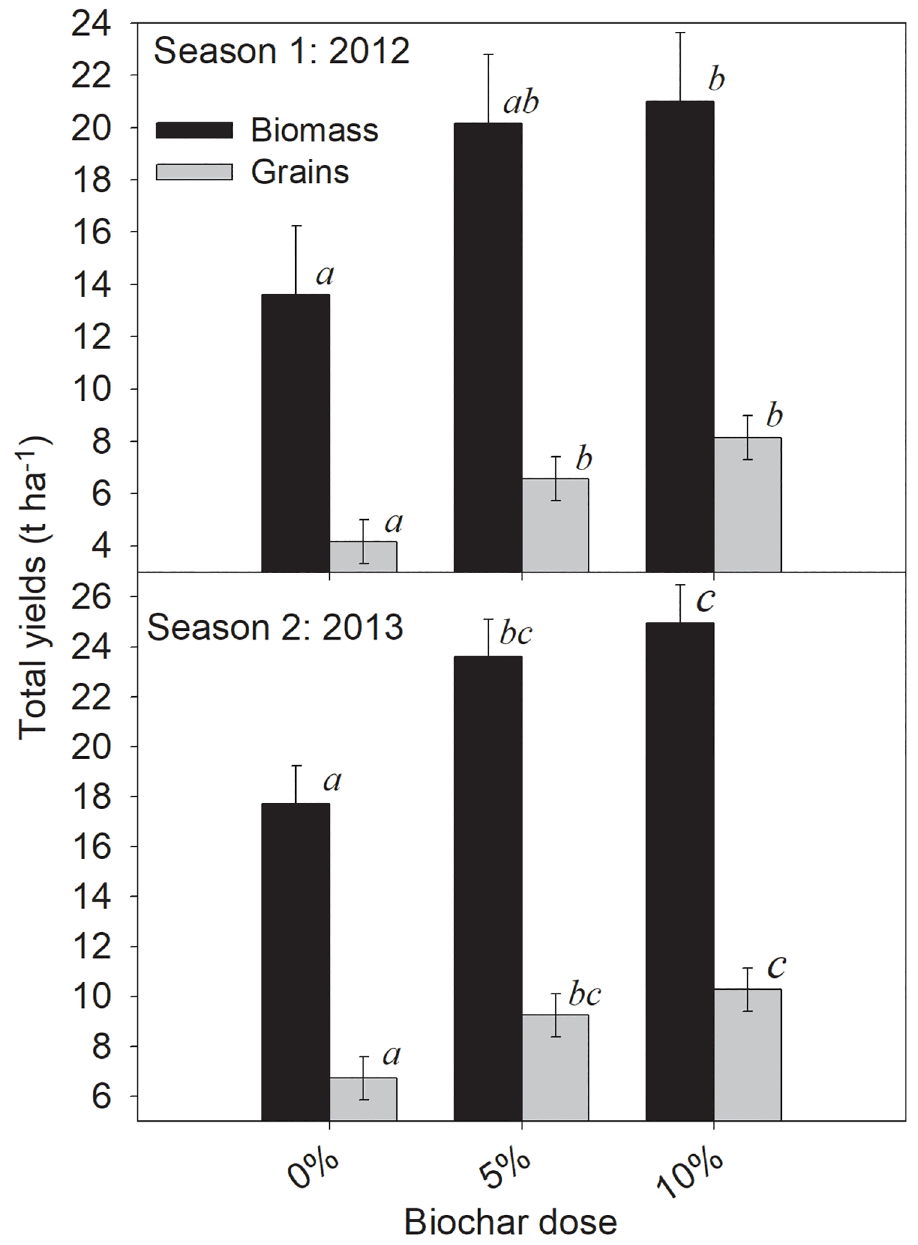
Fig 5. Maize yields from field plots amended with BC. 5 and 10 t ha -1 BC, corresponding to 2.5 and 5% BC, respectively. Means followed by the same letter are not significantly different, Error bars are the standard error, n = 6. Experiment was conducted in heavy clay in West Timor,